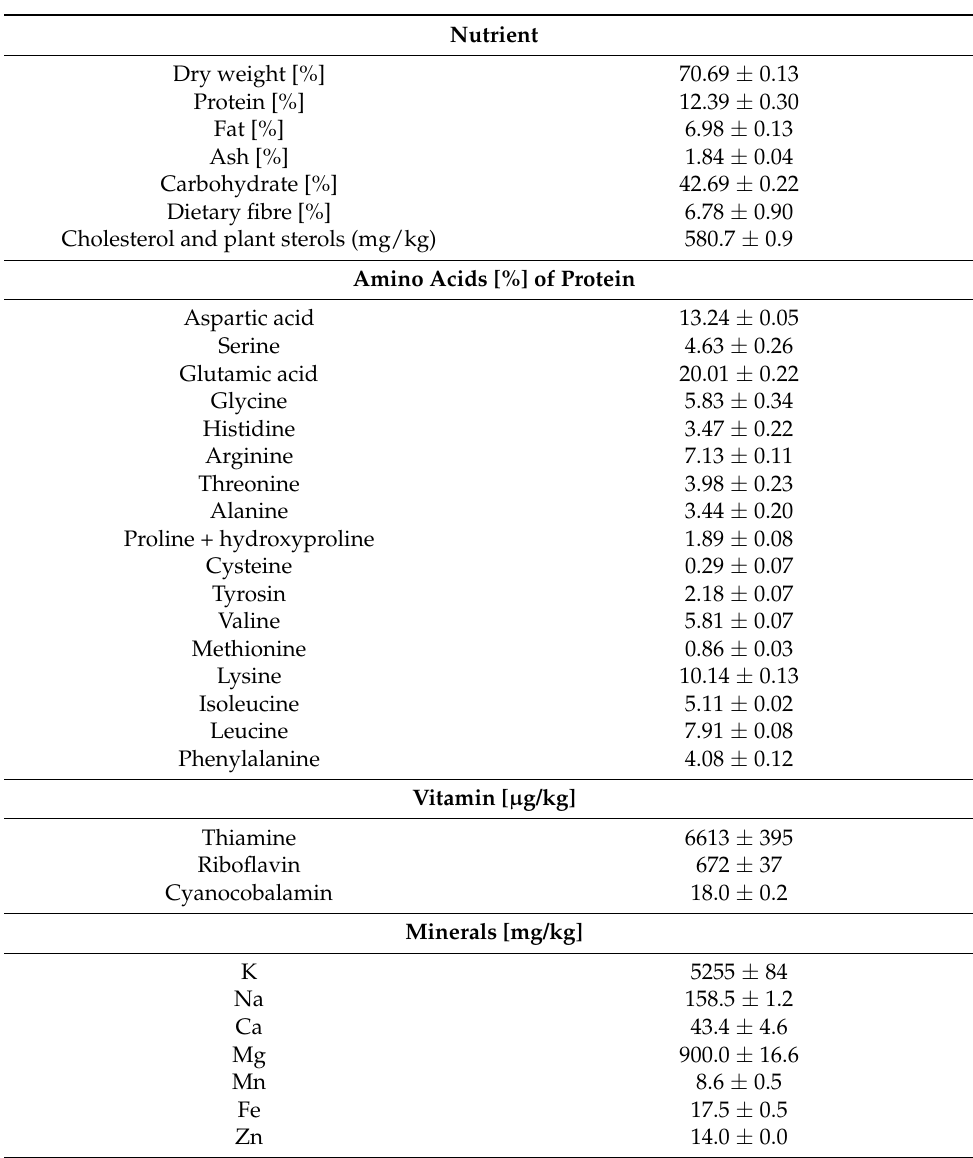
Table 1. Nutritional value of the date bar with addition of fish industry by-products designed according to new